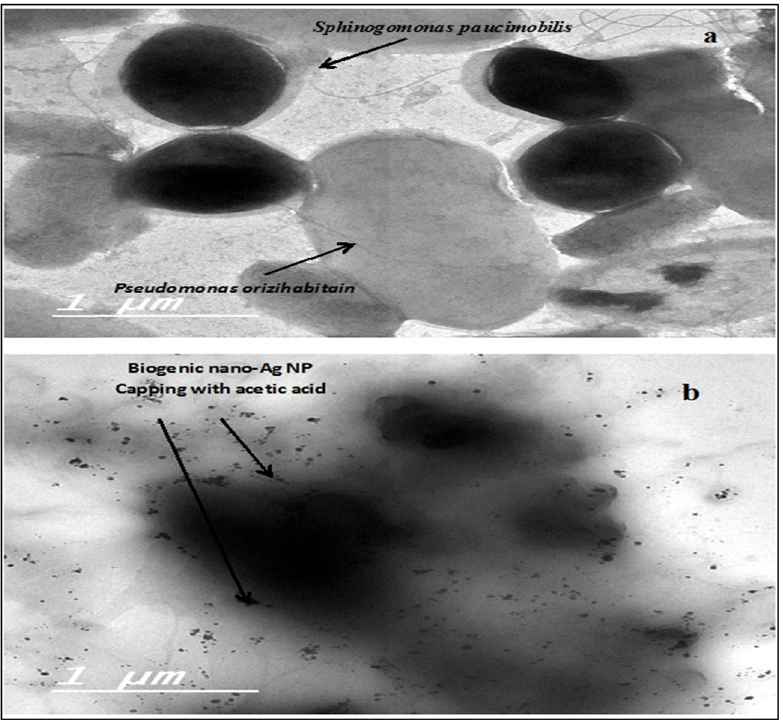
Figure 6: HRTEM examination of detected bacteria ( a ) and morphological e ff ect of biogenic ( AgNPs ) capping with acetic acid in intestinal microbiota of broker chicken ( b )